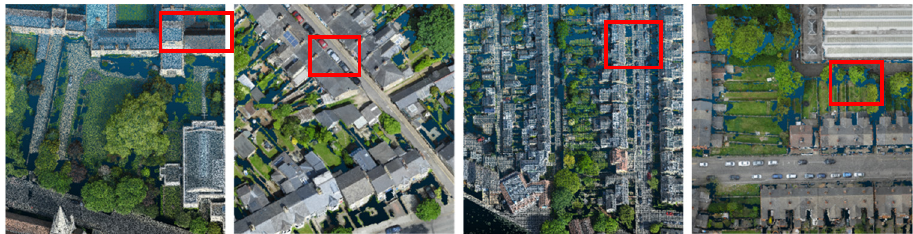
Figure 3. Part of the point cloud data (with missing data) in the SensatUrban dataset. The blue dots correspond to missing information, such as that shown in the red boxes.